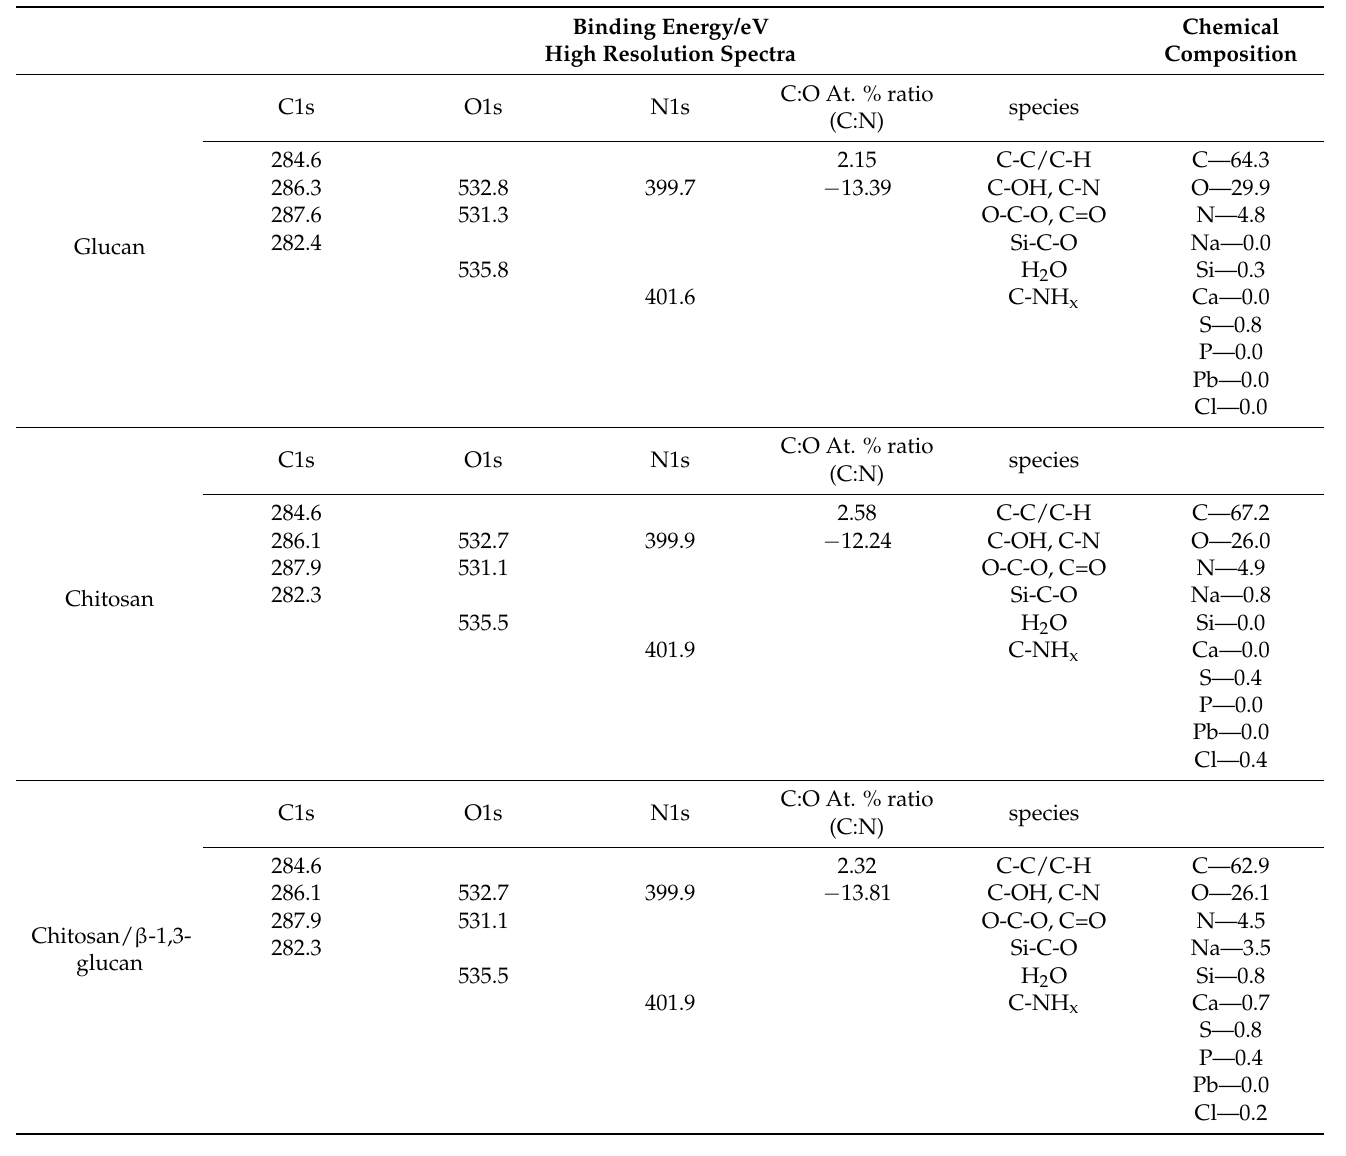
Table 4. C1s , O1s and N1s binding energies (BE, eV) evaluated from a deconvolution procedure of corrected XPS spectra for glucan, chitosan and chitosan/1,3- β - D -glucan